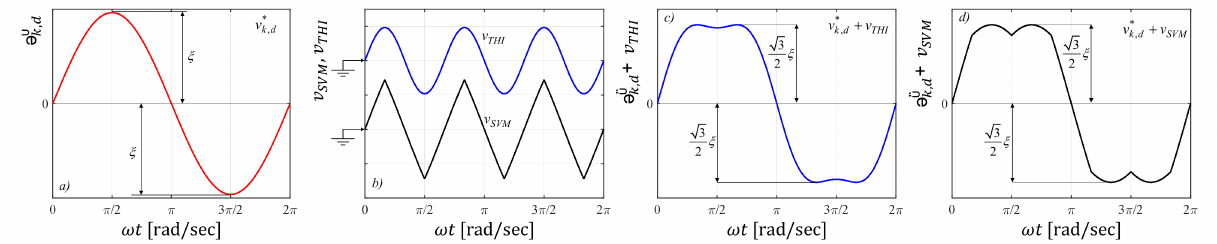
Figure 2. Qualitative waveform of the generic arm reference voltage in the presence of the conventional AC common mode injection: ( a ) Differential component; ( b ) AC conventional common mode components; and ( c , d ) total arm reference voltage AC